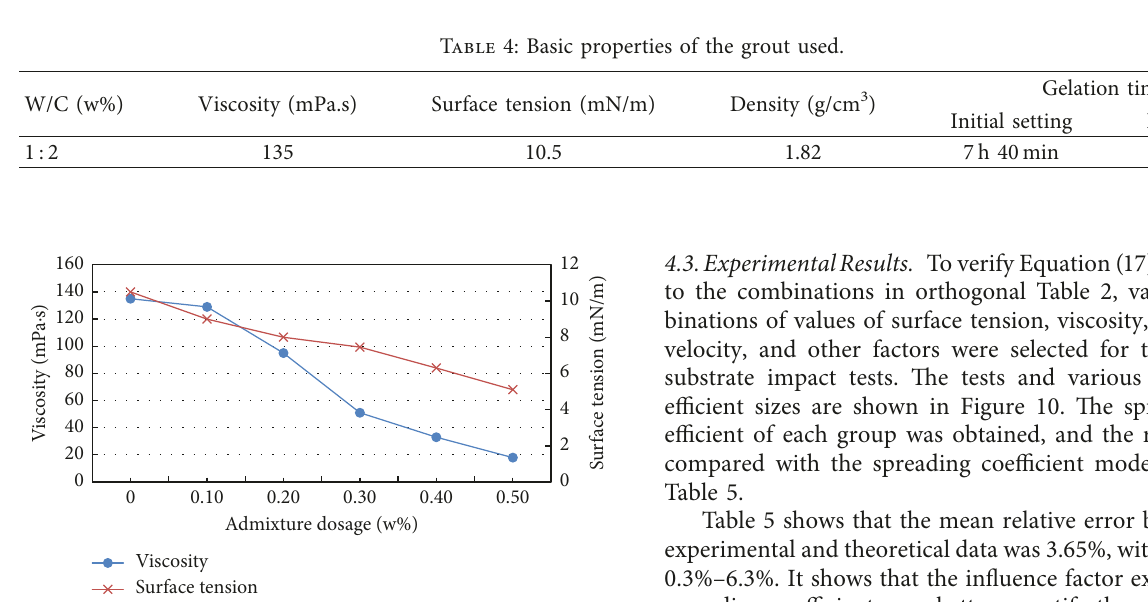
Figure 8: Viscosity and surface tension curves with different amounts of viscosity reducer and modified lignosulfonate.